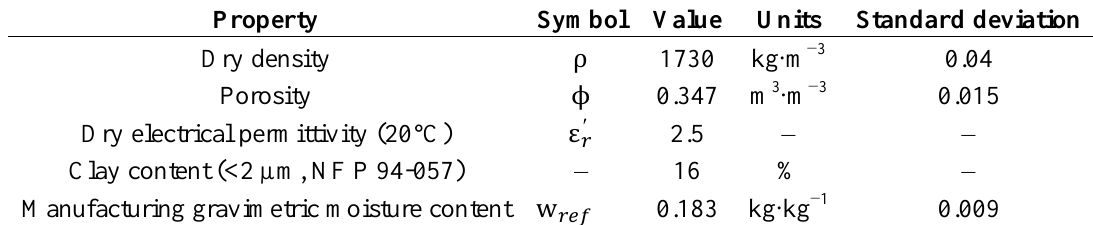
Table 1. Characteristics of the manufactured earth.